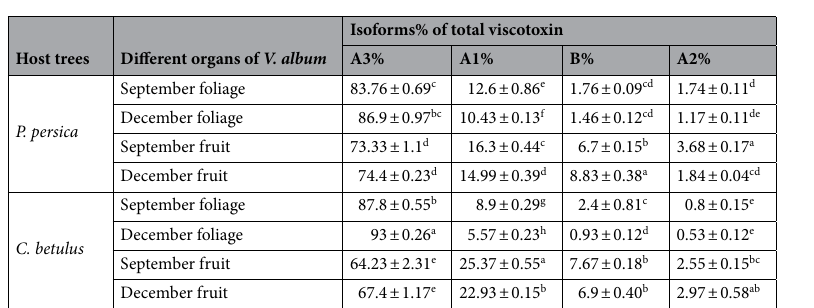
Figure 1. Viscotoxin and lectin concentrations in the foliage and fruit of V. album settled on P. persica and C. betulus in September (Sept.) and December (Dec.). ( a ) Viscotoxins, ( b ) lectins. Each value represents the average of three replicates ± SE. Different letters in figures a and b indicate significant differences at P ≤ 0.01 and P ≤ 0.05 respectively, using the least significant difference test (LSD test).